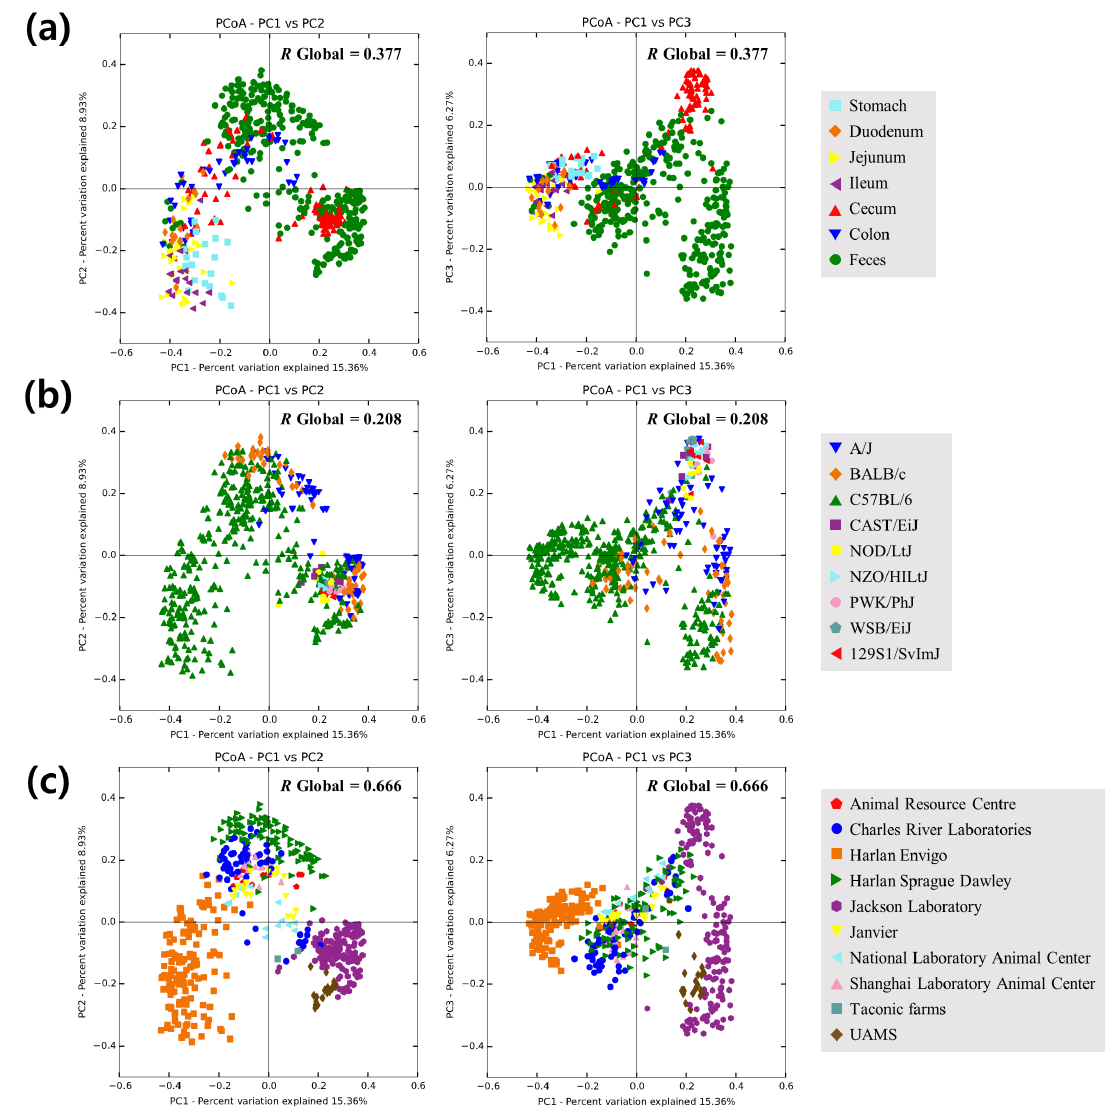
Figure 3. Two-dimensional principal coordinates analysis plot of Bray–Curtis distances with the rarefied number of counts (6266 counts per sample) among the samples. Samples were grouped by ( a ) sampling locations, ( b ) genotypes or ( c ) vendors. Analysis of similarity (ANOSIM) R value is indicated in the upper right of each graph ( p = 0.001 with 999 permutations).